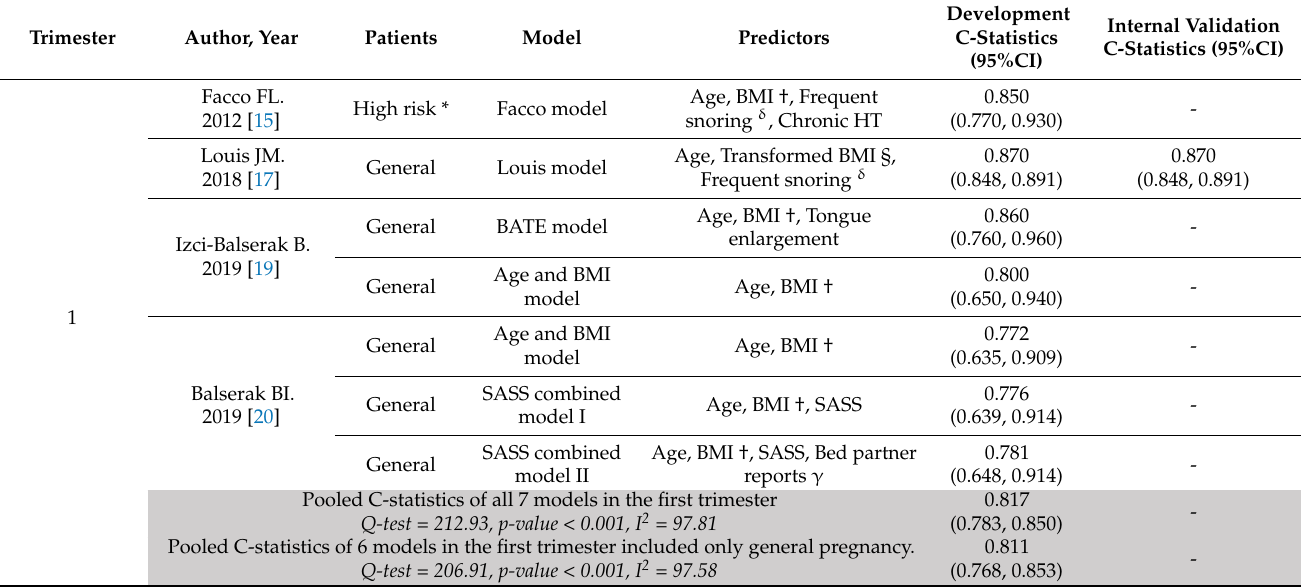
Table 4. Descriptions and meta-analyses of discriminative performances of prediction model in developmental phase for gestational obstructive sleep